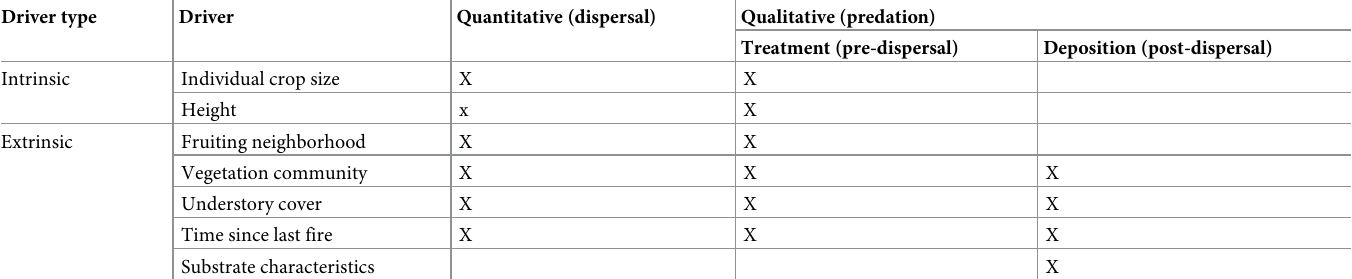
Table 1. Intrinsic and extrinsic drivers investigated for effects on the quantitative component and qualitative subcomponents of seed dispersal effectiveness in L . subcoriacea